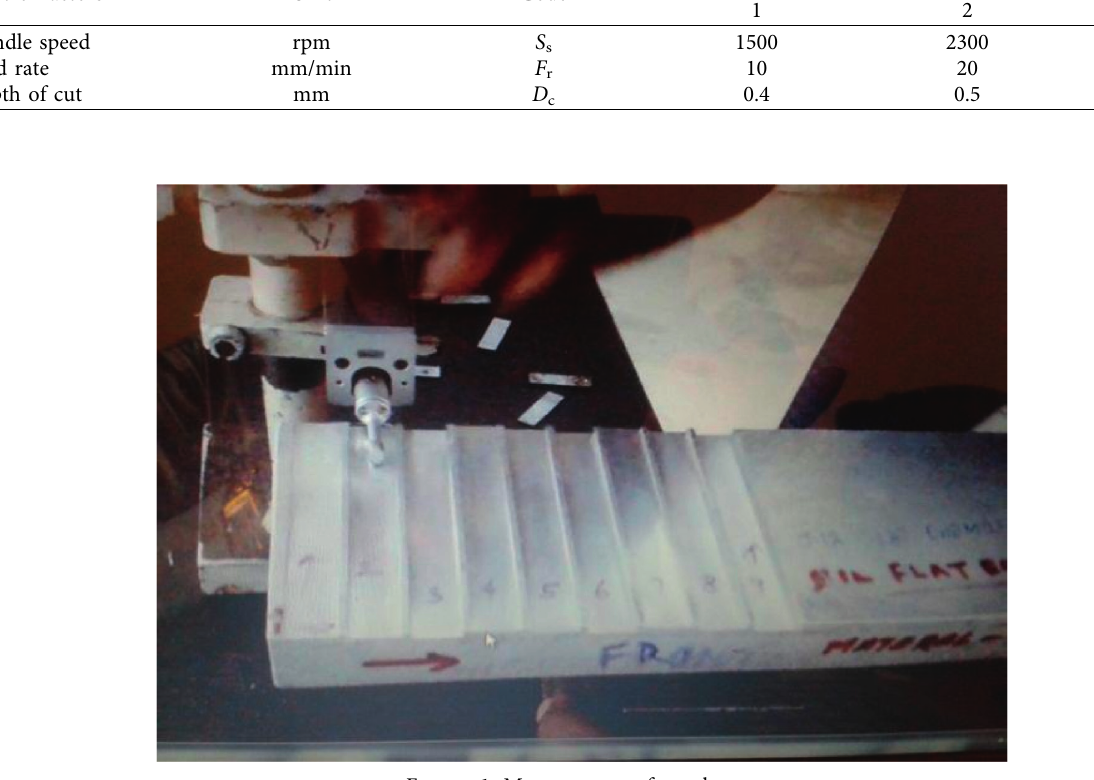
Figure 1: Measurement of roughness. Table 3: Experimental runs and responses.